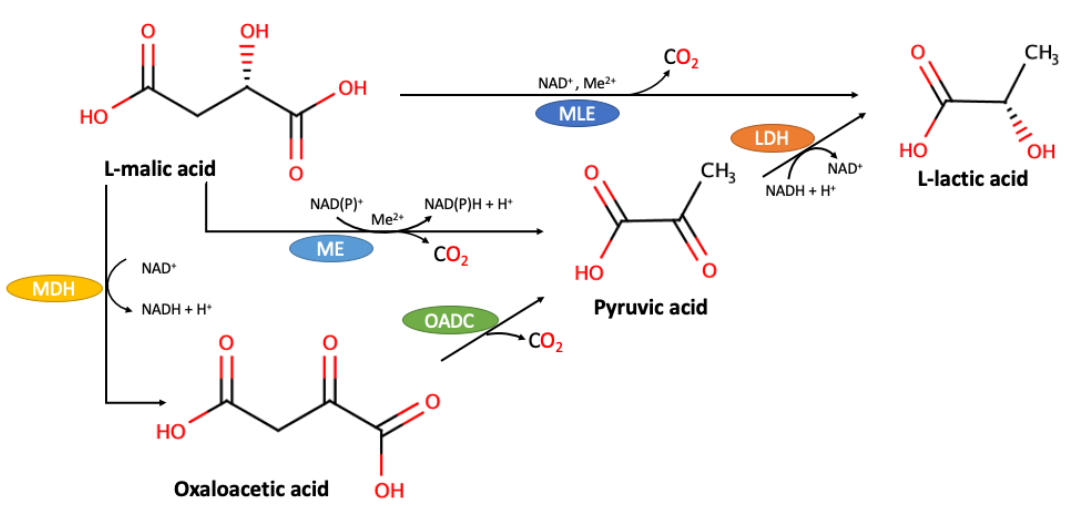
Figure 1. Possible decarboxylation pathways for the enzymatic conversion of l -malic acid to l -lactic acid. MDH, malate dehydrogenase; ME, malic enzyme; MLE, malolactic enzyme; OADC, oxaloacetate decarboxylase; LDH, lactate dehydrogenase. Adapted from Schümann et al. (2013) [14].